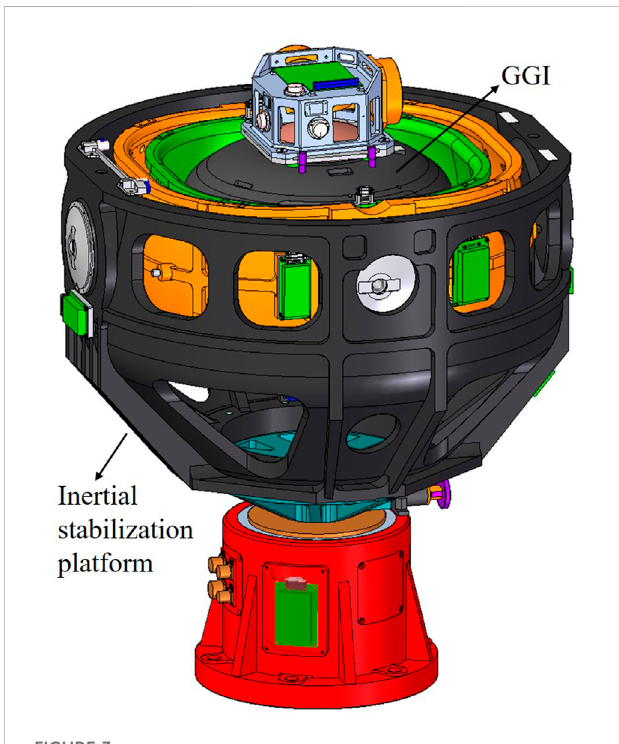
FIGURE 3 Installation structure diagram of inertial stabilization platform and GGI.